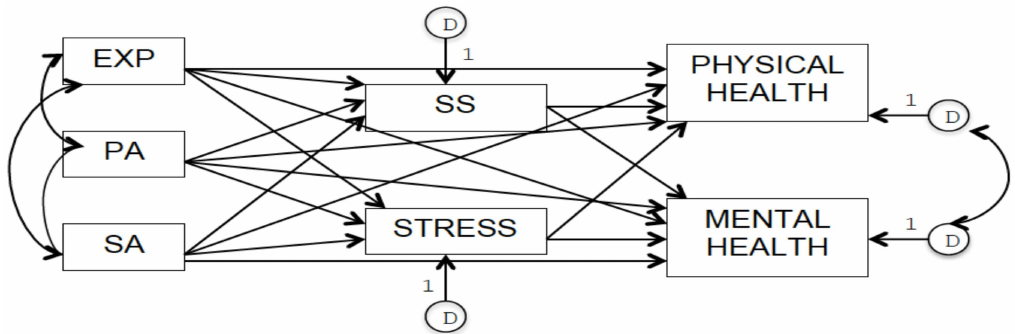
Figure 1. Model 1 representing direct and indirect e ff ects of childhood exposure (EXP) to intimate partner violence (IPV), physical abuse (PA), and sexual abuse (SA) on adult physical and mental health through adult self-perceived social support (SS) and self-perceived everyday life stress (STRESS).